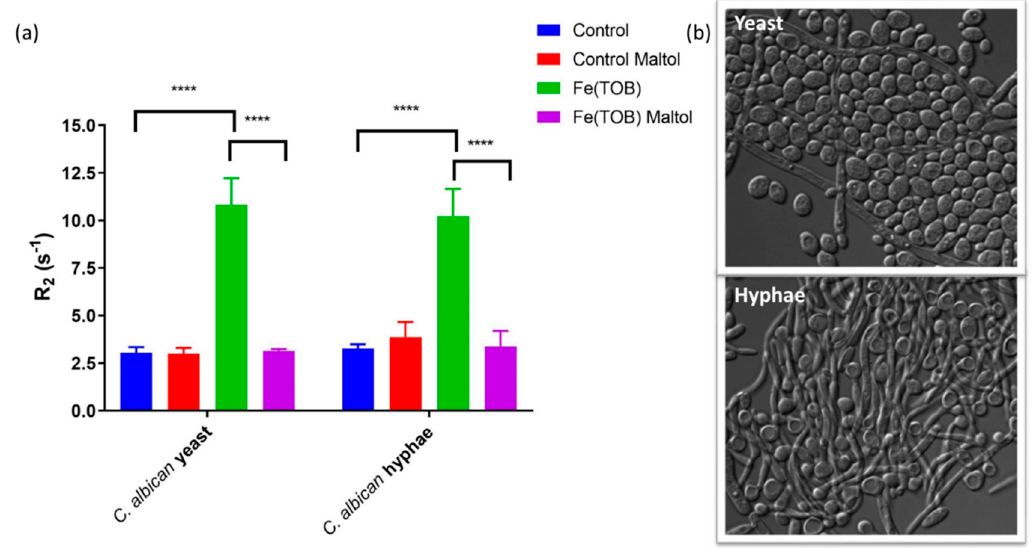
Figure 4. Scanning electron micrograph of the control and Fe(TOB)-labeled S. cerevisiae . The detection limit of the Fe(TOB)-labeling was investigated by mixing the Fe(TOB)-labeled cells with control cells in both the C. albicans yeast and hyphae. The percentage of Fe(TOB)-labeled cells was increased while keeping the total protein content of the samples constant at 125 µg/mL protein (Figure 5). The samples were uniformly suspended in 15% ( w / v ) gelatin and the T 1 and T 2 constants were measured for the samples. As expected, the water proton T 1 constants did not change markedly upon the addition of Fe(TOB)-labeled cells (Figure S24). On the other hand, the T 2 effect on water protons increased with the increase of Fe(TOB)-labeled cells (Figure 6).